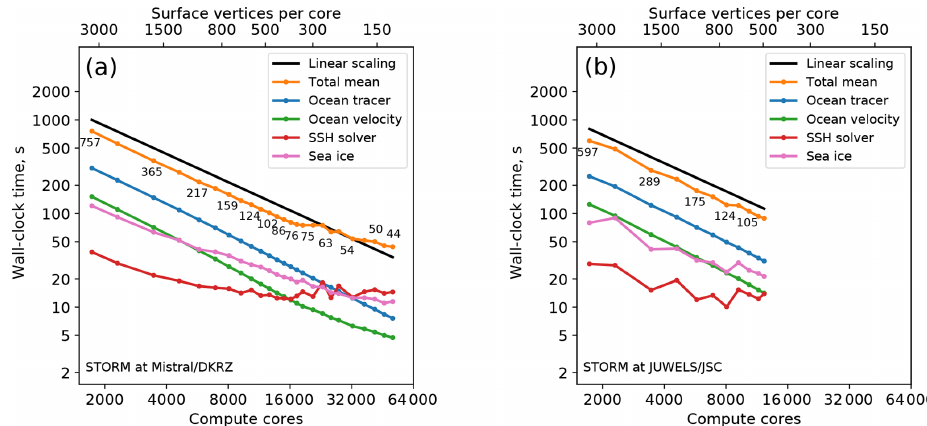
Figure 3. Scaling results for the STORM mesh on Mistral (DKRZ Hamburg, a ) and JUWELS (JSC Jülich, b ) compute clusters. The black line indicates linear scaling and the orange line (and the number labels) gives the mean total computing time over the parallel